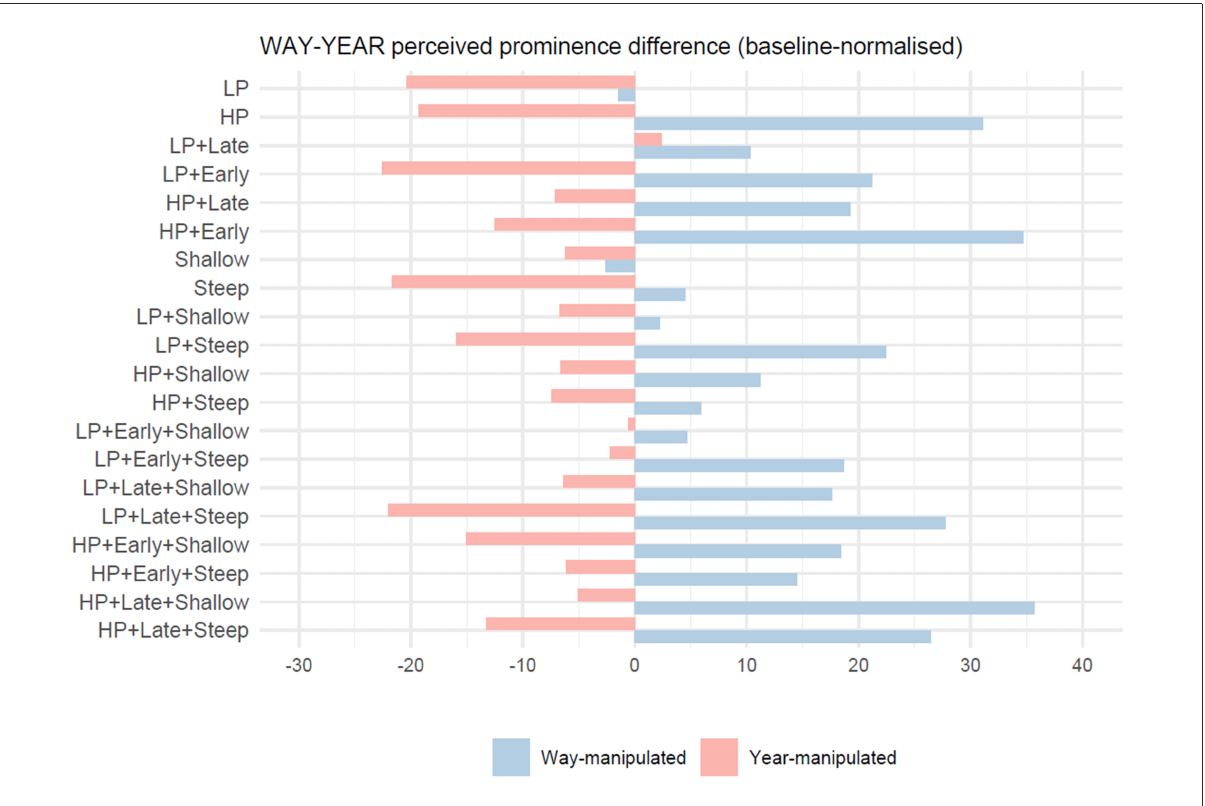
FIGURE8 The difference in perceived prominence of WAY and YEAR syllables within the same stimulus, baseline-normalized (Test 2).